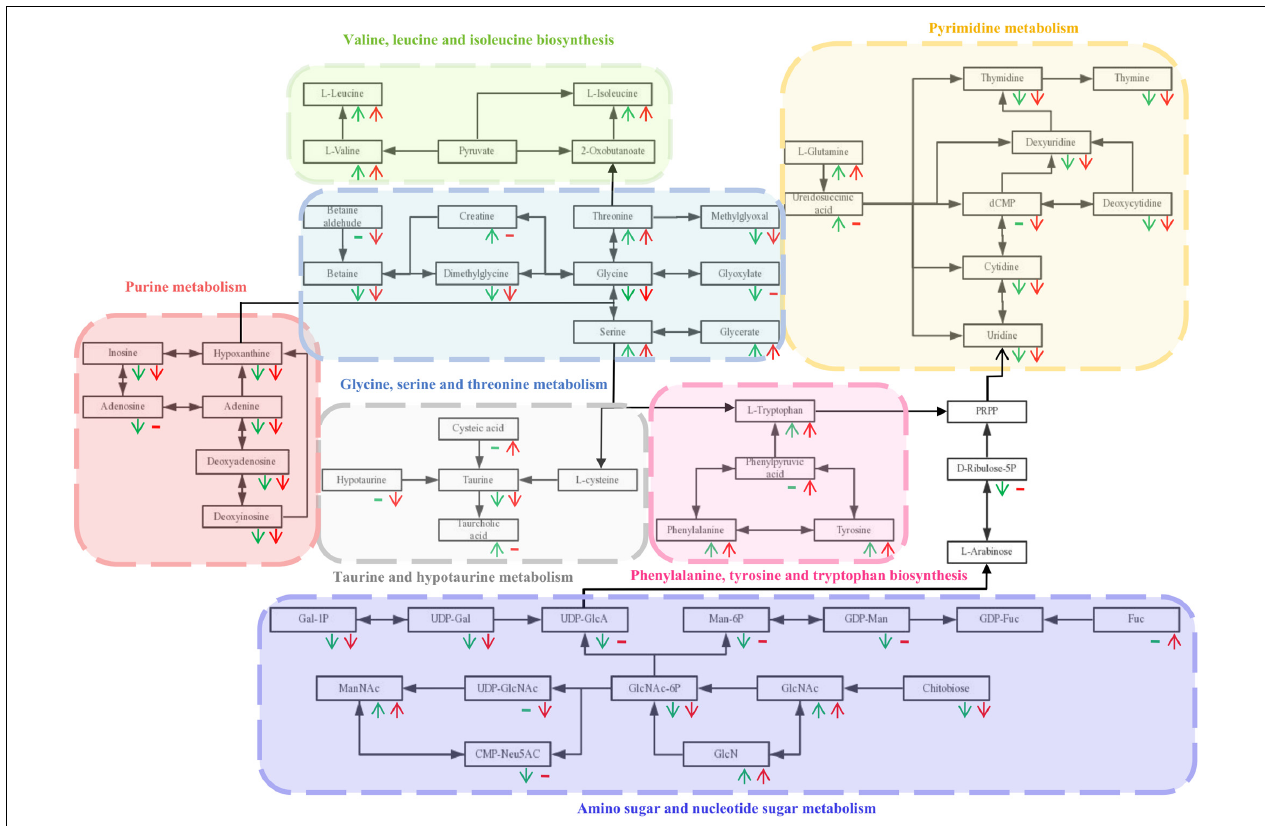
FIGURE 8 | The integrated metabolic pathway shared in 4 and 8 wpi during C. sinensis infection. Beneath each metabolite, green and red represent 4 and 8 wpi compared with the control, respectively. The arrows indicate up and down-regulation of metabolites, respectively. Horizontal lines indicate that the metabolites are not significantly different in this infection